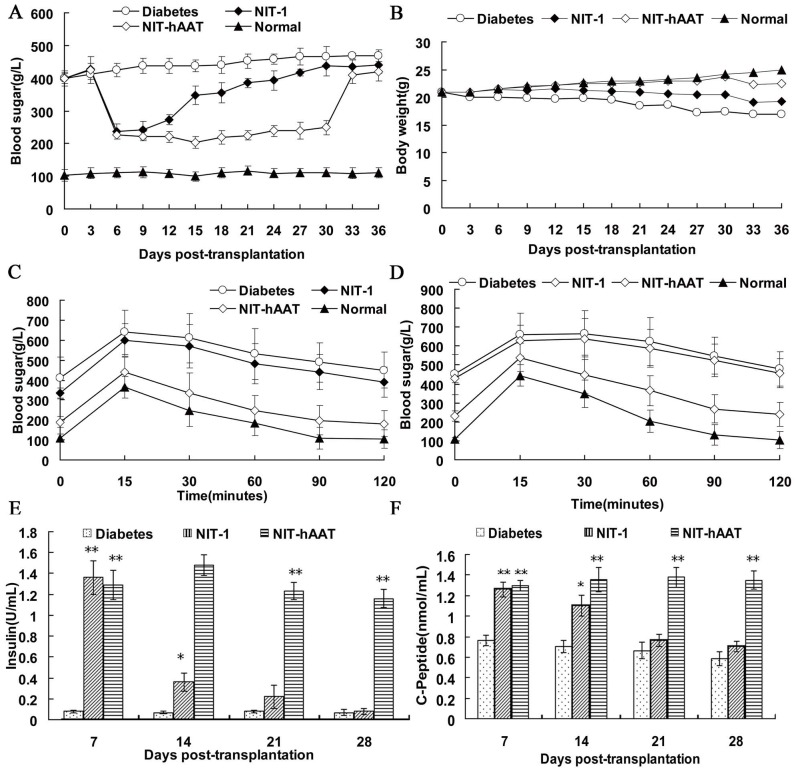
Transplantation of NIT–hAAT cells into STZ-treated diabetic mice.NIT-1 or NIT–hAAT cells were transplanted into diabetic mice. After transplantation, the blood sugar level, body weight, glucose tolerance, and insulin and C-peptide concentrations were monitored. (A) Blood sugar levels of the recipients (n = 10). (B) Changes in the body weight of the recipients (n = 10). (C,D) GTT at 14 d (c) or 28 d (d) after transplantation (n = 5). (E) In vivo glucose-stimulated insulin secretion in the recipients (n = 5). (F) In vivo C-peptide levels in the recipients (n = 5). *P-value <0.05,**P-value <0.01 compared with the diabetic group.